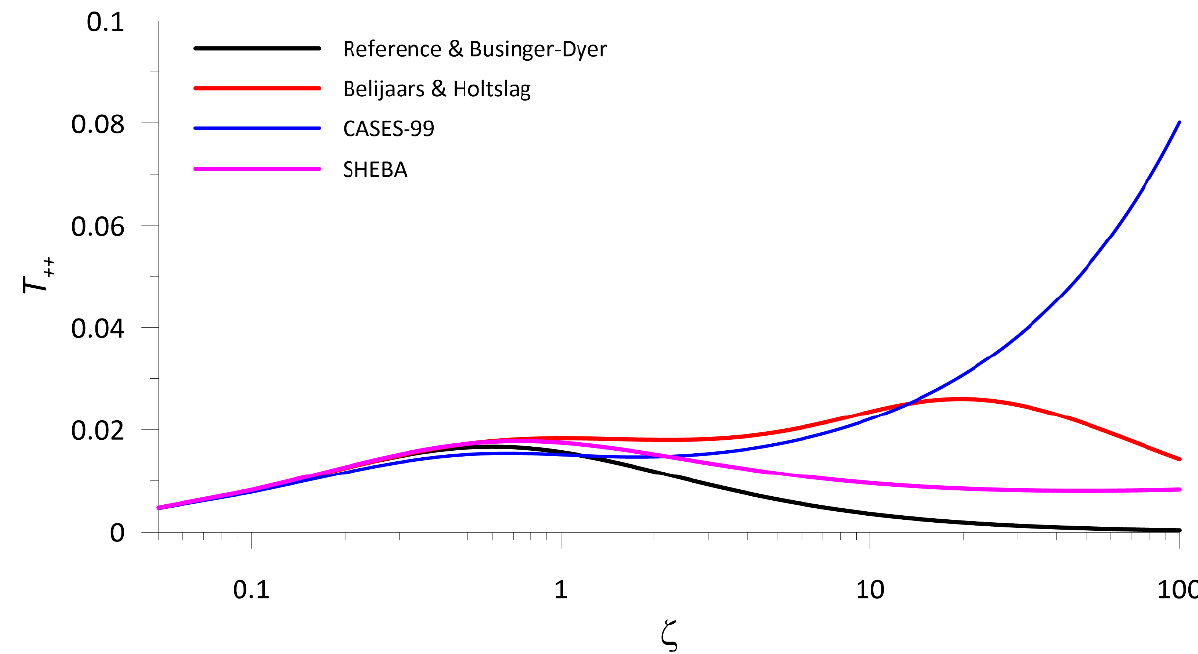
Figure 5. Evolution of 𝑇 (cid:2878)(cid:2878) as a function of the stability parameter 𝜁 for the four Ψ (cid:3040) listed in Section 3 ( z (cid:2868) .= 0.5 m).